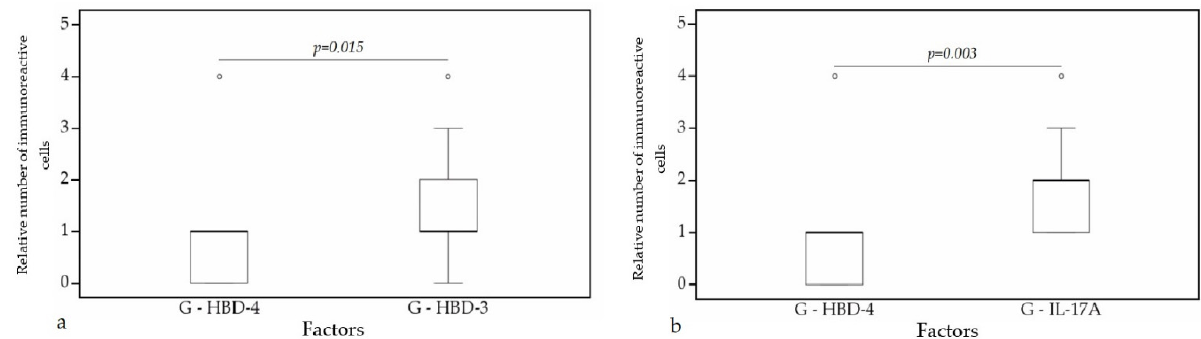
Figure 12. Wilcoxon test revealing statistically significant difference between the relative numbers of different factors in glands. ( a ) A statistically significant difference between HBD-4 and HBD-3 in glands. ( b ) A statistically significant difference between HBD-2 and LL-37 in glands. G, glands; HBD-3, human β defensin 3; HBD-4, human β defensin 4; IL-17A, interleukin 17A; o—outlier data—indicates a higher or lower number of relative positive cells which lie more than 1.5 but less than 3.0 times the interquartile range below the first quartile or above the third quartile.